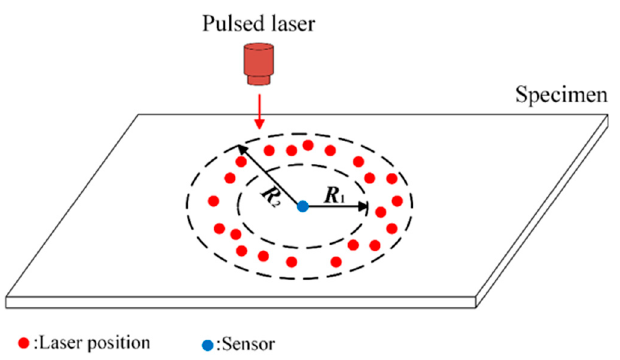
Figure 4. Experimental scheme of reference measurements.